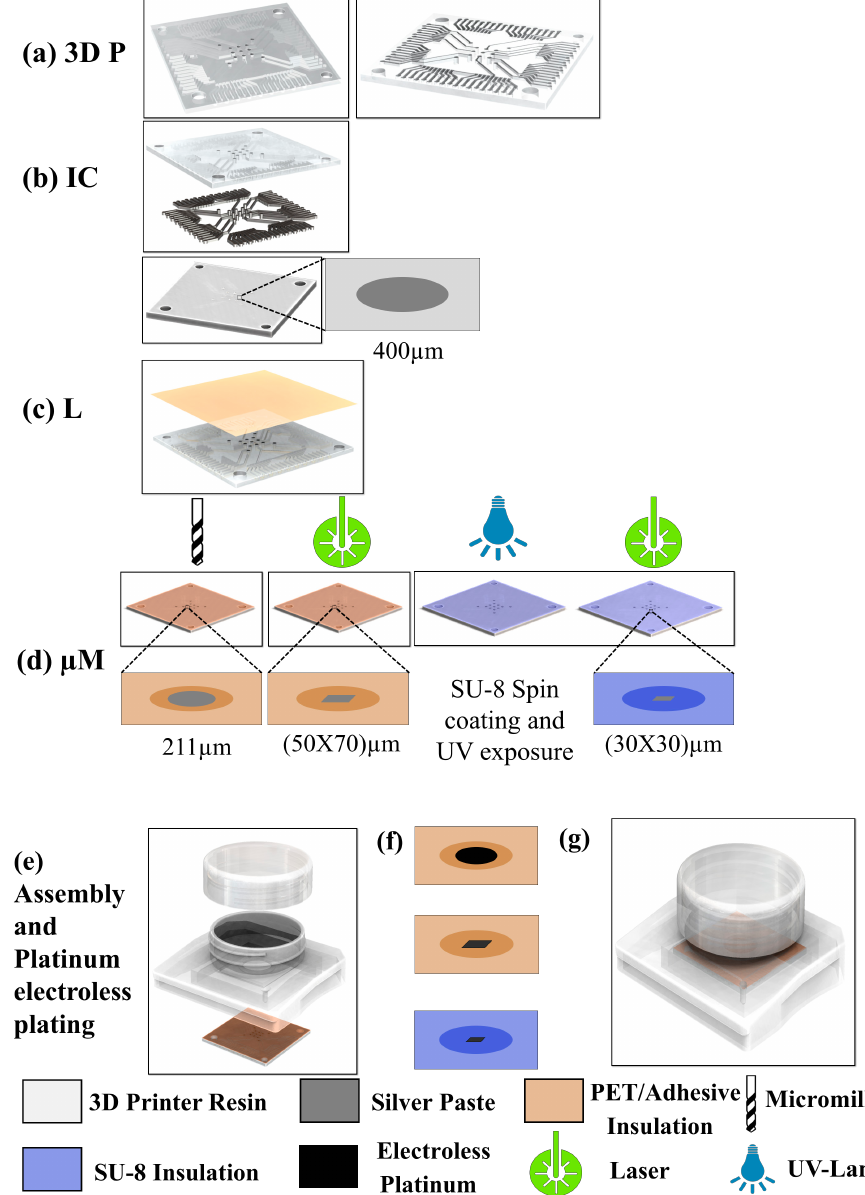
Figure 1. ( a ) 3D design of the microelectrode array (MEA) used for 3D printing (3D P); ( b ) ink casting (IC) of silver paste on the bottom face of the MEA; ( c ) lamination (L) of an insulation layer or casting/curing of SU8; ( d ) micromachining (μM) process by micromilling or laser micromachining; ( e ) assembly and platinum electroless plating for the definition of low impedance electrodes; ( f ) individual electrodes of different sizes after platinum electroless plating; ( g ) final, fully assembled device ready for testing.